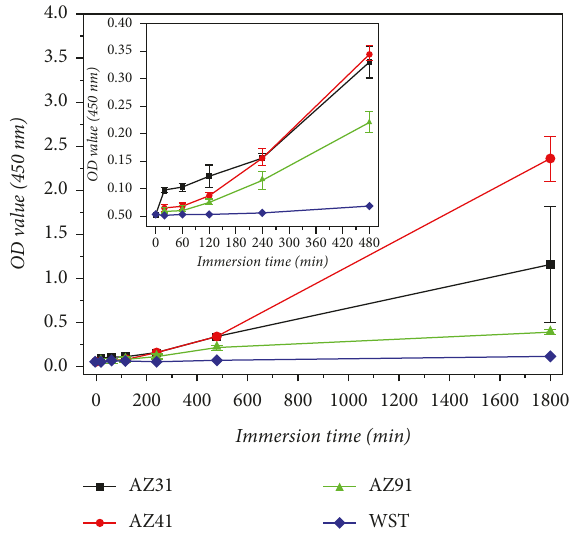
Figure 6: The OD values of the solutions monitored with a microplate reader along with the immersion